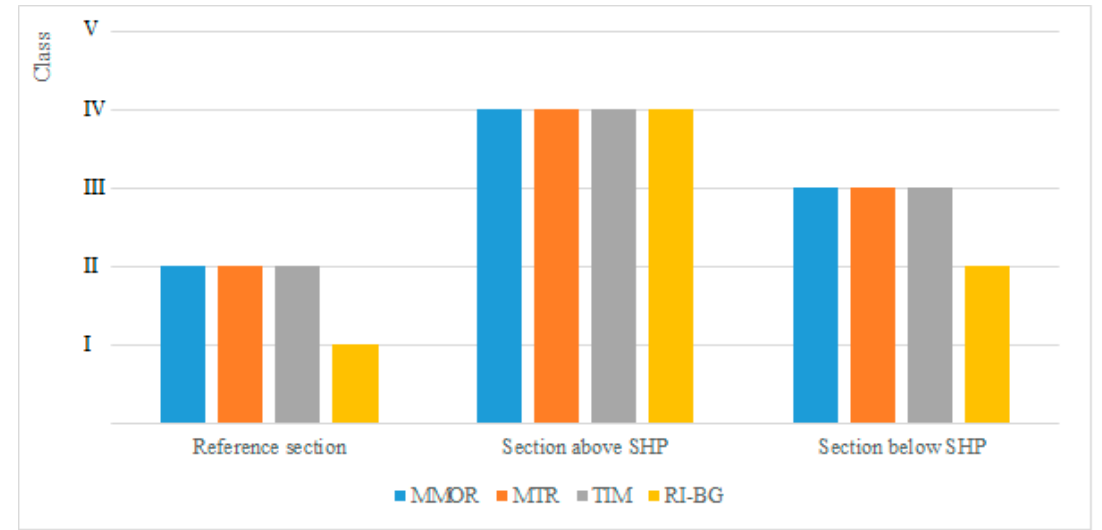
Figure 4. Comparison of ES results obtained using MMOR, MTR, TIM and RI-BG.